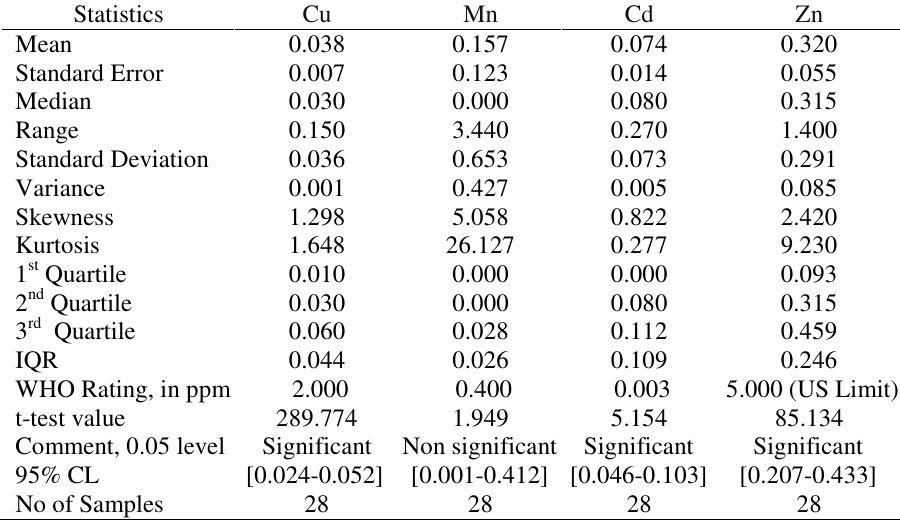
Figure 3. Variation of metal contents of groundwater outside the tea gardens. Table 3. Descriptive statistics of the metal contents of groundwater in the study area.